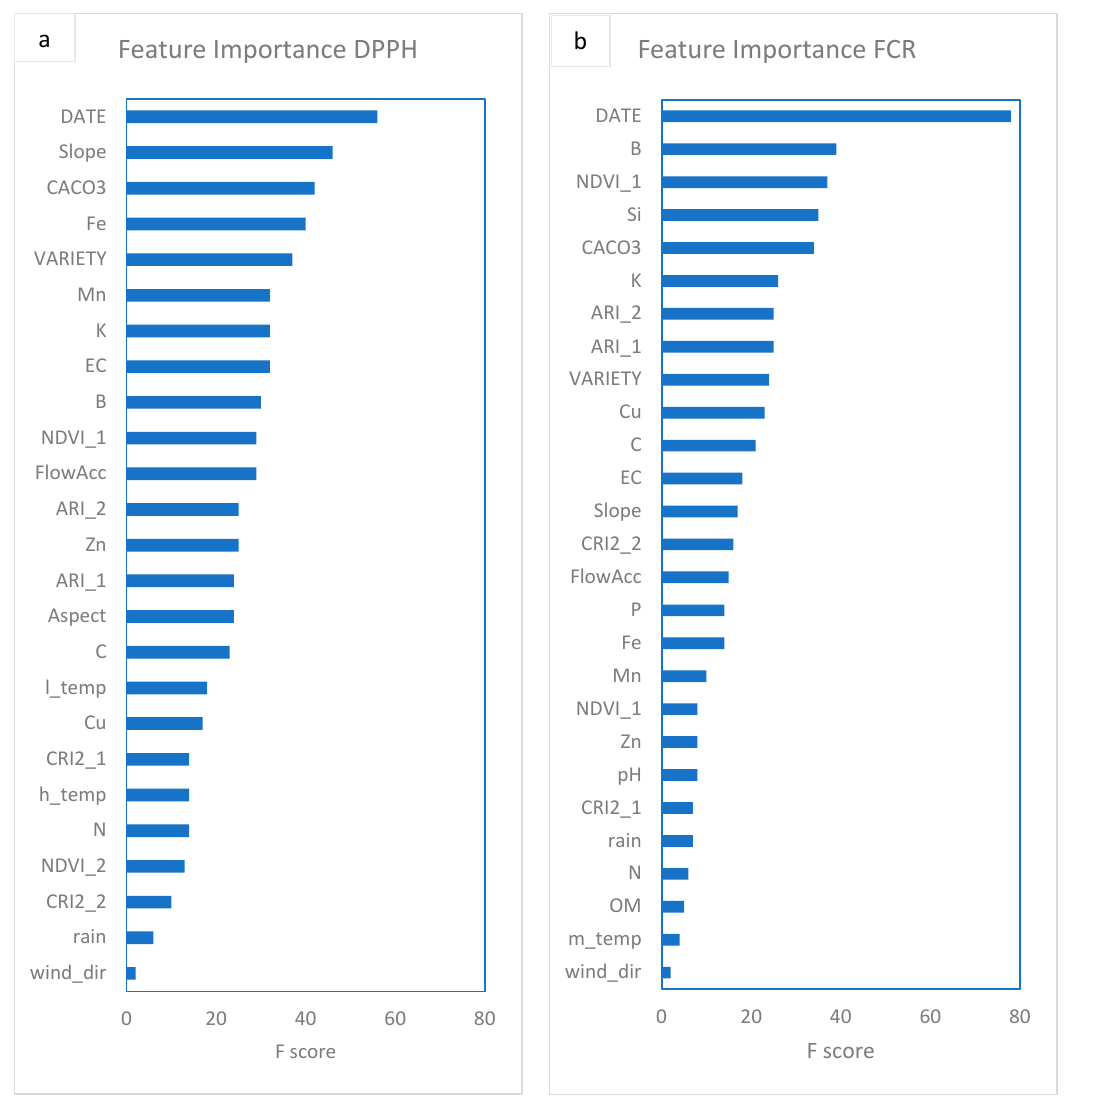
Figure 8. The results of feature evaluation using F-score method for DPPH ( a ) and FCR ( b ) features for 2018 data.